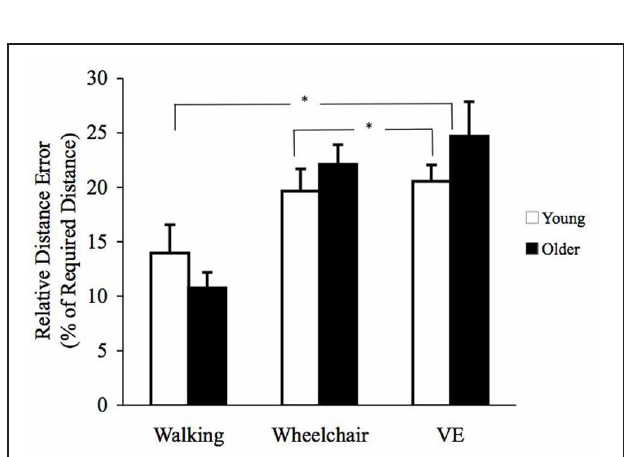
error (RRE) for young (filled diamond) and older (filled square) participants. Age differences were significant in the wheelchair ( ∗ p < 0 . 05) and VE ( ∗ p < 0 . 01) conditions.